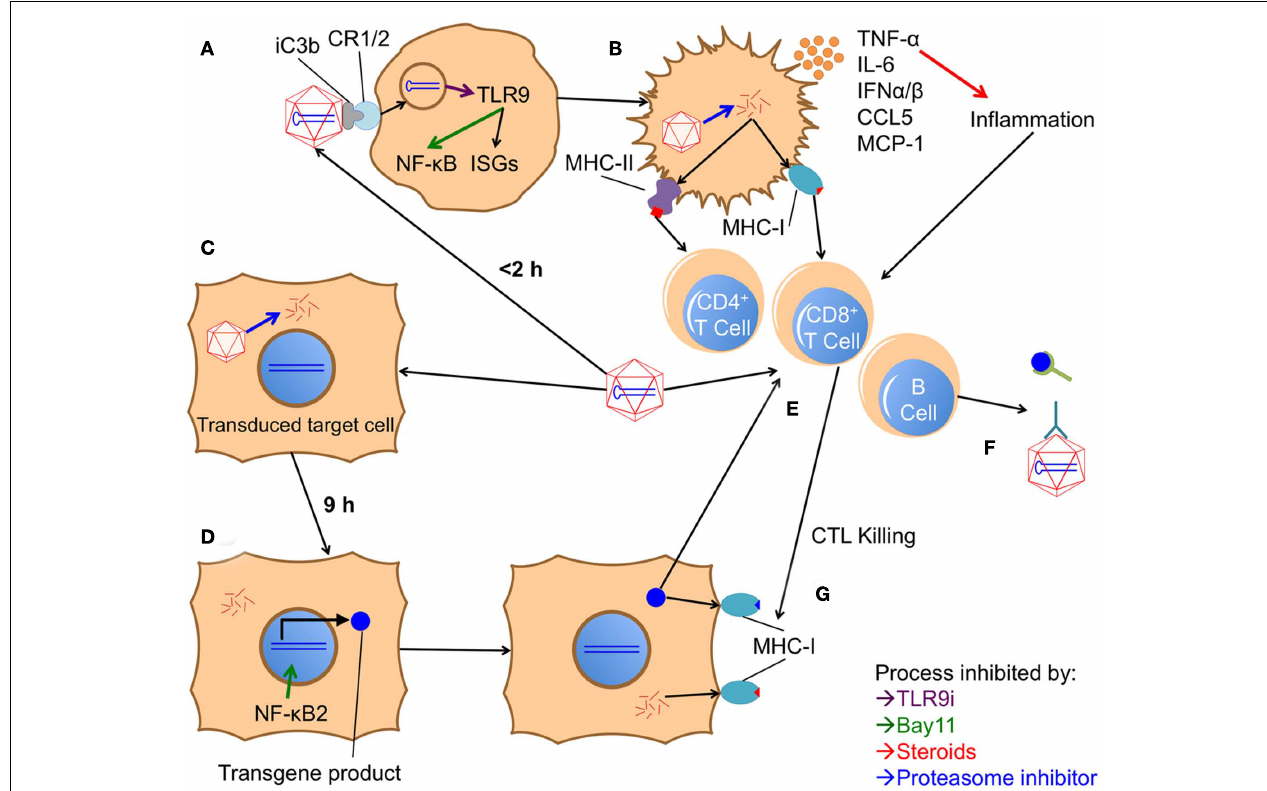
enhancing expression of the transgene product. Bay11 can also blockade this NF- κ B pathway. (E) Over the course of several days, the inflammatory signals from internalized AAV particles and the local environment induce maturation of APCs. Activation of the alternative NF- κ B pathway in these APCs may enhance transgene expression and cross-presentation, augmenting their ability to prime an adaptive response (involving B cells, inhibiting further transduction, and against the transgene product, inhibiting its efficacy. (G) Capsid or transgene specific CD8 + T cells recognize peptide fragments of either protein in class I MHC on transduced cells. Recognition prompts the CTLs to attack and kill the target cell. Death of a significant number of transduced cells can lead to a reduction or complete elimination of transgene expression. Capsid-specific CTL killing can be reduced by inhibiting capsid degradation in target cells with proteasome